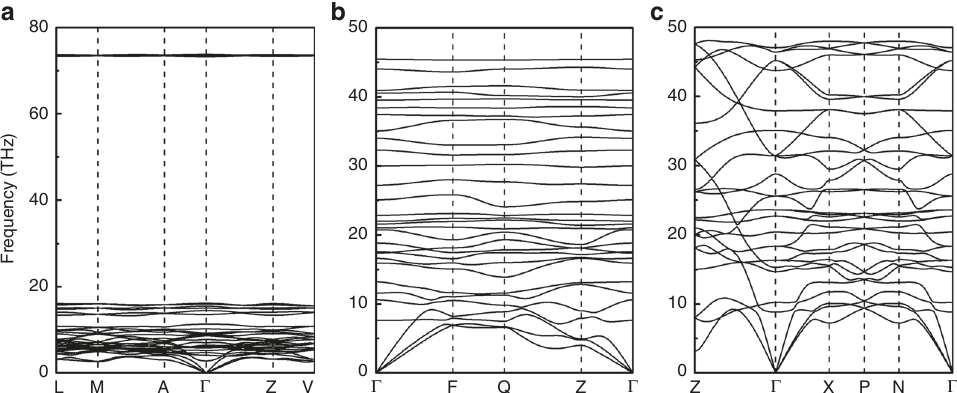
Fig. 3 Phonon dispersions of HeN 4 . Phonon dispersions of HeN 4 with the C 2/ c structure at 25 GPa ( a ), the P 1 structure at 80 GPa ( b ) and the I 4 1 / a structure at 100 GPa ( c )